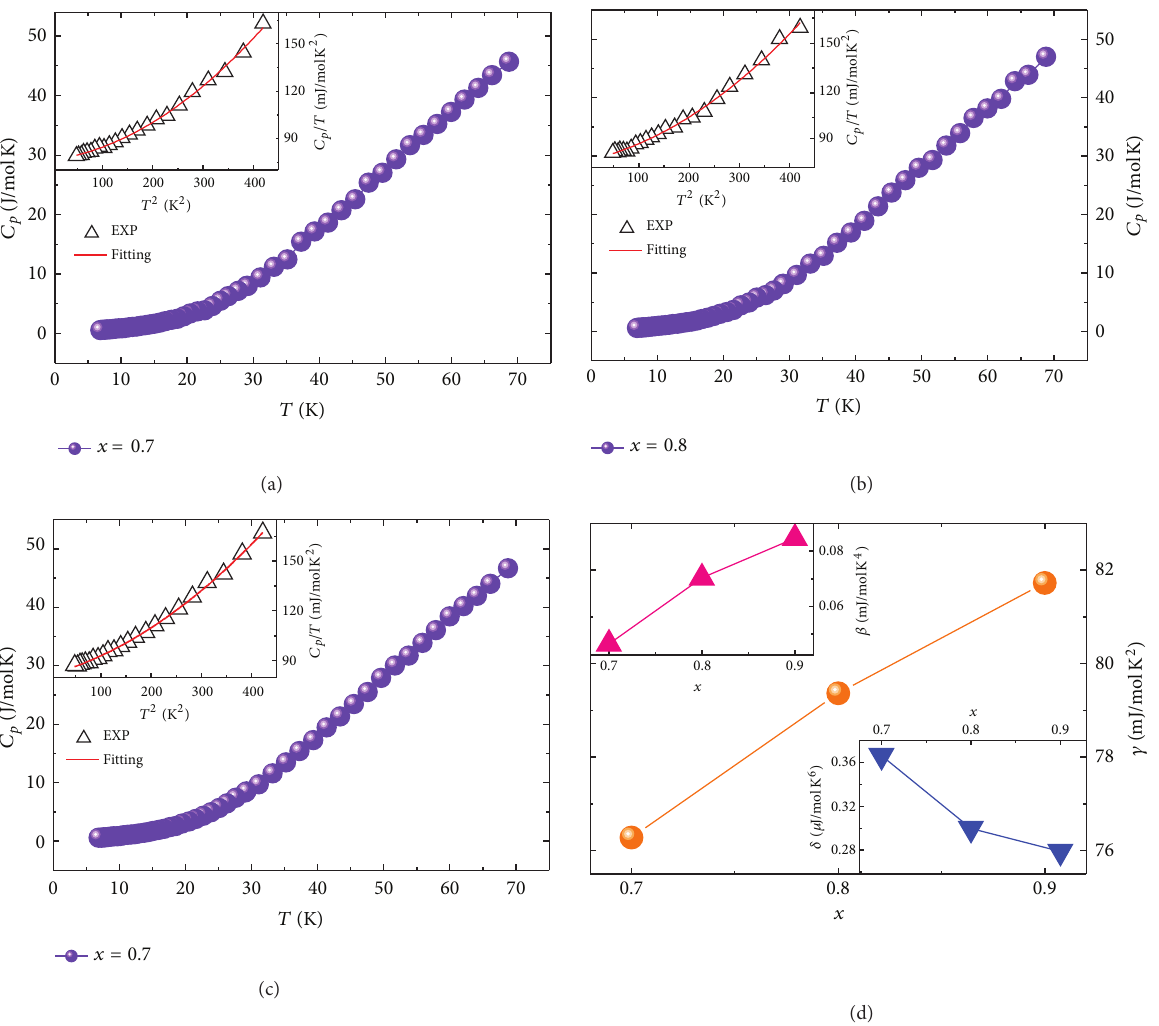
F 6: (Color online) (a)–(c) Temperature-dependent heat capacity ( T ) at zero magnetic �eld for GaCFe ) between ( T )/ T versus below 20K and the solid line represents the �tting results according to (1). (d) e 6.7 and 70K; inset shows the plots of �tting parameter ; the le and right insets show the parameters as a function of x , 𝐶𝐶 𝑃𝑃 2 𝑇𝑇 𝐶𝐶 𝑃𝑃